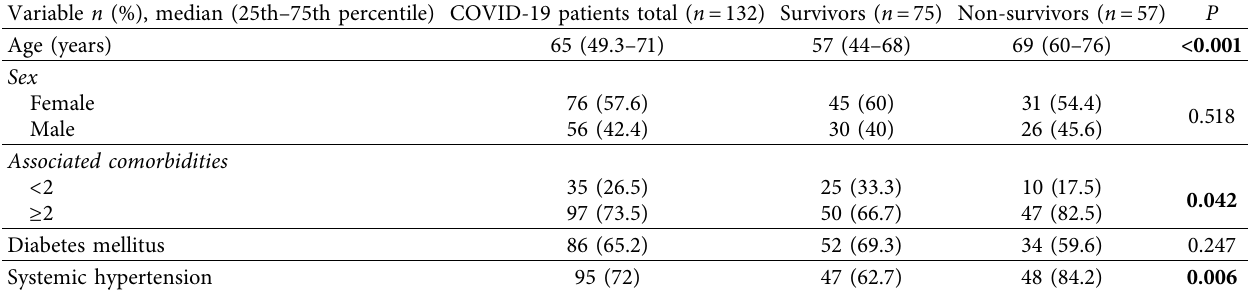
Table 1: Demographic data and associated comorbidities of the study COVID-19 cases ( n � 132)